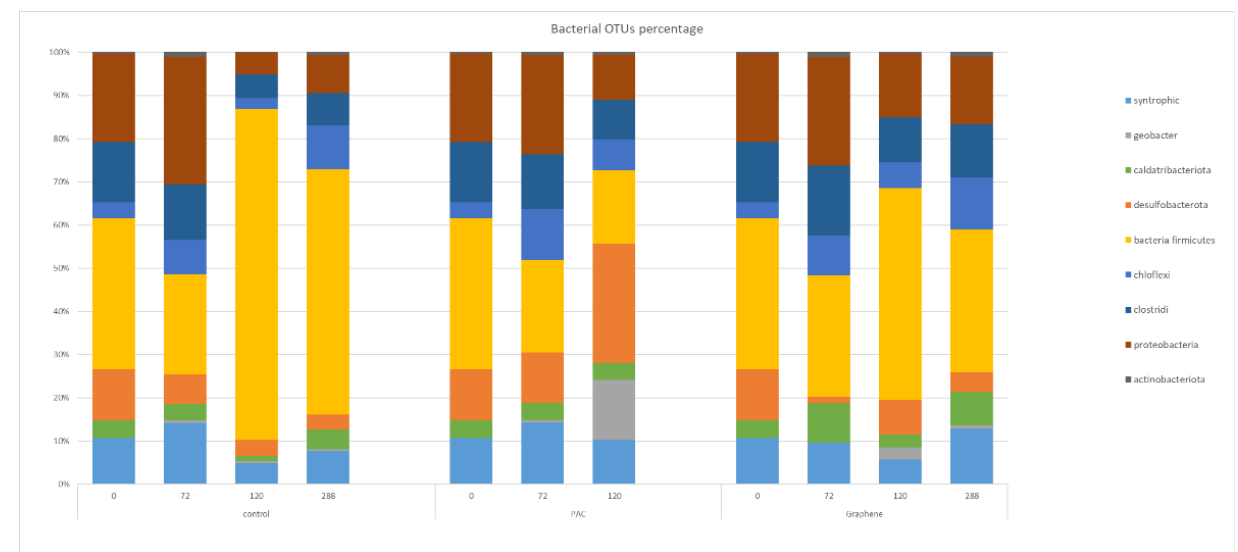
Figure 6. Structure of bacteria communities in the different treatments and time expressed as functional relevant OTUs percentage. OTUs with an abundance lower than 0.05% are grouped together as “other”.